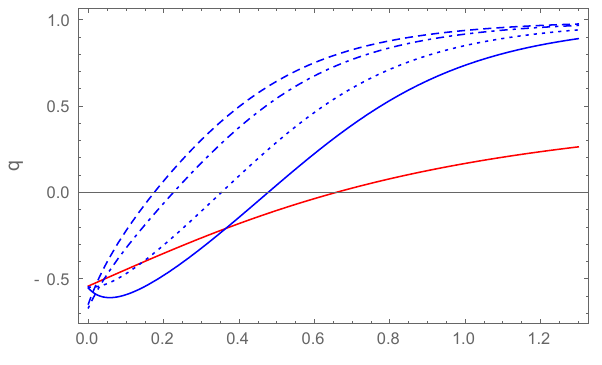
Figure 6. Variation of the deceleration parameter, q , as a function of z for K µν = ( β 3 R + γ 3 T ) T µν with different values of the parameters b 3 and g 3 : b 3 = 0.073 and g 3 = 0.1 (solid curve), b 3 = 0.08 and g 3 = 0.097 (dotted curve), b 3 = 0.15 and g 3 = 0.30 (dashed curve), and b 3 = 0.21 and g 3 = 0.12 (dot-dashed curve). The evolution of the deceleration parameter in the standard Λ CDM model is described by the red solid